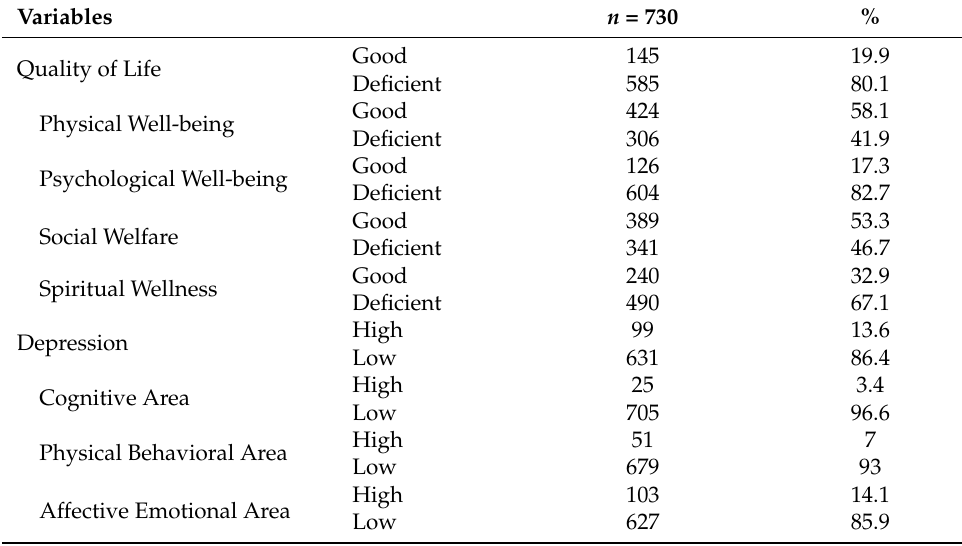
Table 2. Descriptive analysis of the study